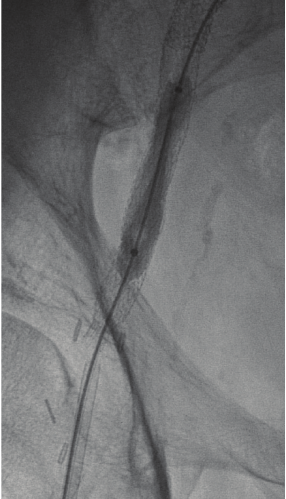
Figure 1: Controlled ruptured of the iliac artery with balloon angioplasty of a covered